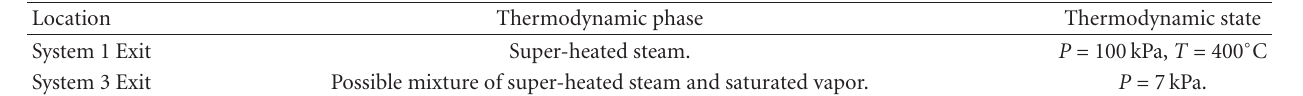
Table 2: Operating conditions for Systems 1 and 3.